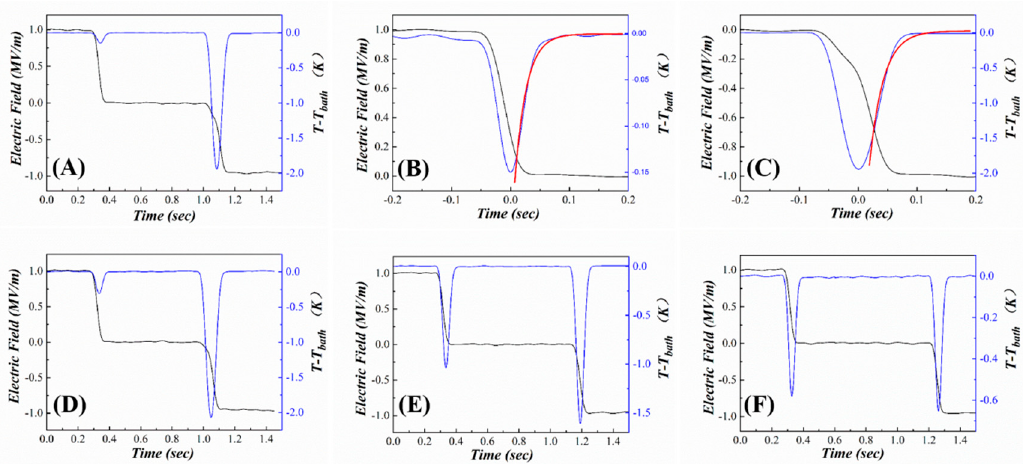
Figure 1. The electrocaloric effect (ECE) signals of [110] direction of PMN-PT single crystal at 1 MV/m. ( A ) ECE measured @ 296 K; ( B ) Fitting of 1st signal in Figure 1A; ( C ) Fitting of 2nd signal in Figure 1A; ( D – F ) ECE measured @ 353, 383, and 418 K, respectively.